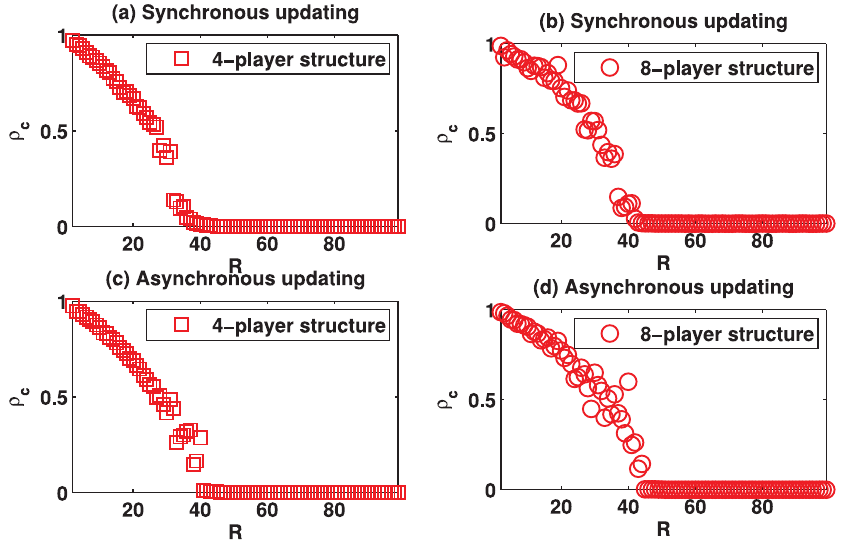
Figure 1. (Color online) Cooperation level as a function of the parameter r c R on different square lattices under the best-take-over rule with uniform initial strategies distribution. (a) Results on the square lattice with 4-player neighborhood and synchronous updating; (b) Results on the square lattice with 8-player neighborhood and synchronous updating; (c) Results on the square lattice with 4-player neighborhood and asynchronous updating; (d) Results on the square lattice with 8-player neighborhood and asynchronous updating.